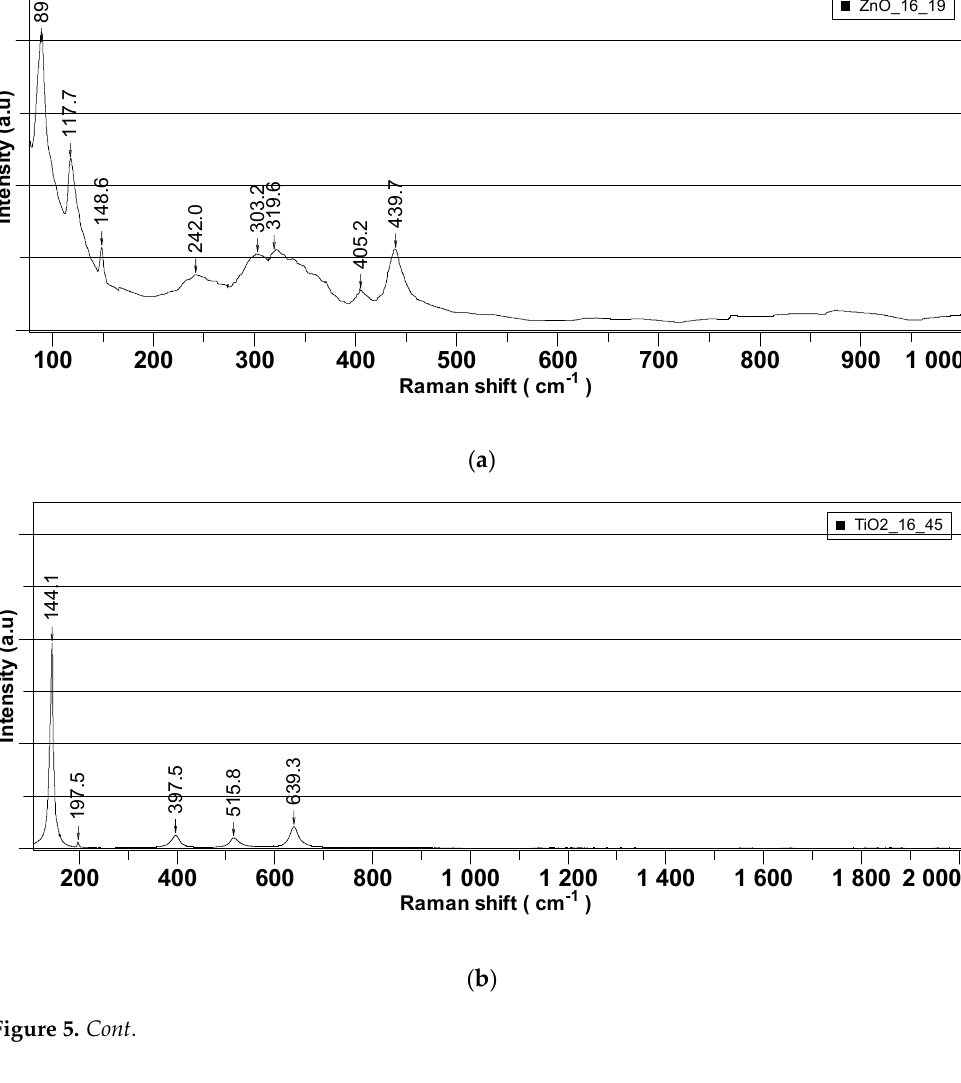
Figure 4. XRD patterns of the synthesized nanoparticles: ( a ) ZnO, ( b ) TiO 2 , and ( c ) zeolite. Figure 5 presents the Raman spectra recorded for each of the synthesized nanoparti- cles, which were further employed as active components in the decontamination